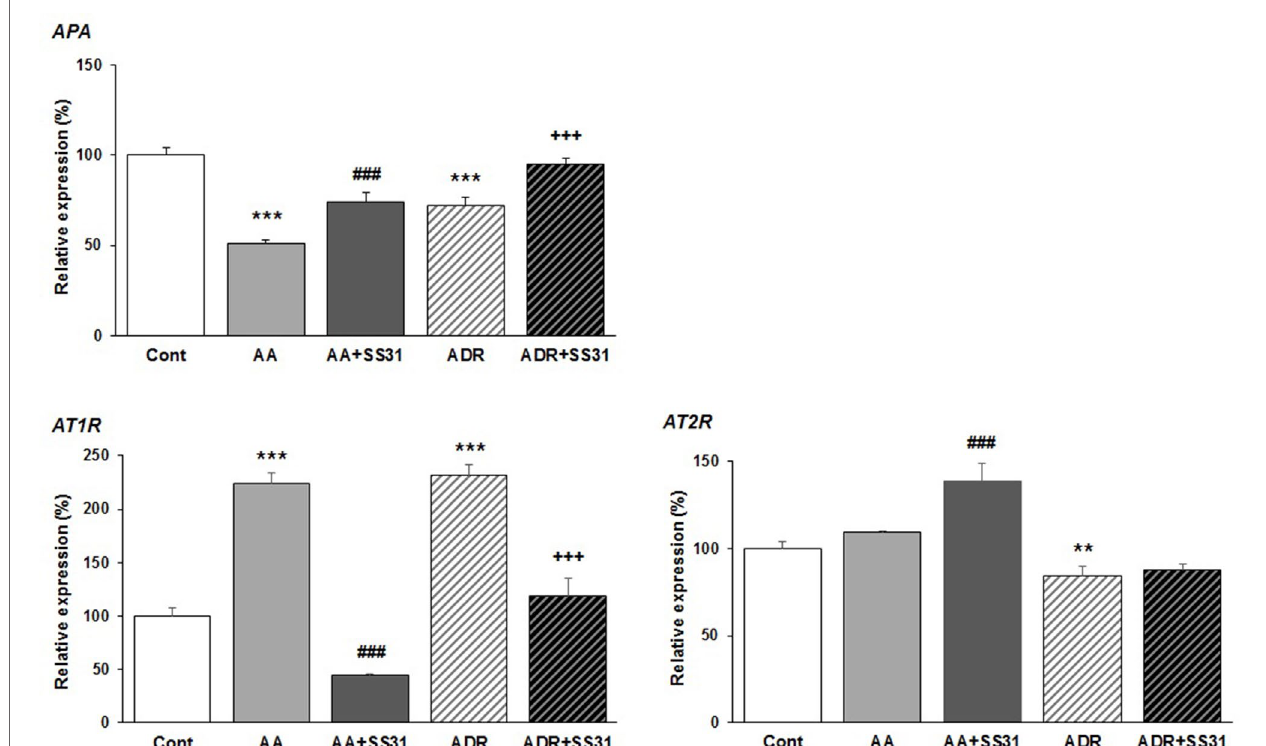
FIGURE 4 | Modulation of genes of the renin–angiotensin system in the kidneys of mice exposed to aristolochic acid or adriamycin, without or with SS-31. After 7 days of treatment with either aristolochic acid (AA) or adriamycin (ADR), alone or together with SS-31 (+SS31), the animals (n = 5 mice per experimental group) were sacrificed and their kidneys retrieved for the determination by qRT-PCR of the mRNA levels of genes of the components of the renin–angiotensin system (RAS). Healthy wild-type BALB/c male mice were used as controls (Cont). The levels of expression of the mRNAs for aminopeptidase A (APA), the AT 1 and AT 2 angiotensin receptors were quantified by qRT-PCR. Results were averaged for all animals in each experimental group and are presented as % of changes in the mRNA levels in the treated animals versus control animals ± sem.*: AA or ADR compared to Cont; # : AA + SS-31 or + : ADR + SS-31 compared to AA or ADR alone, respectively. (*p < 0.05; **p < 0.01; ***p < 0.001; applies to all